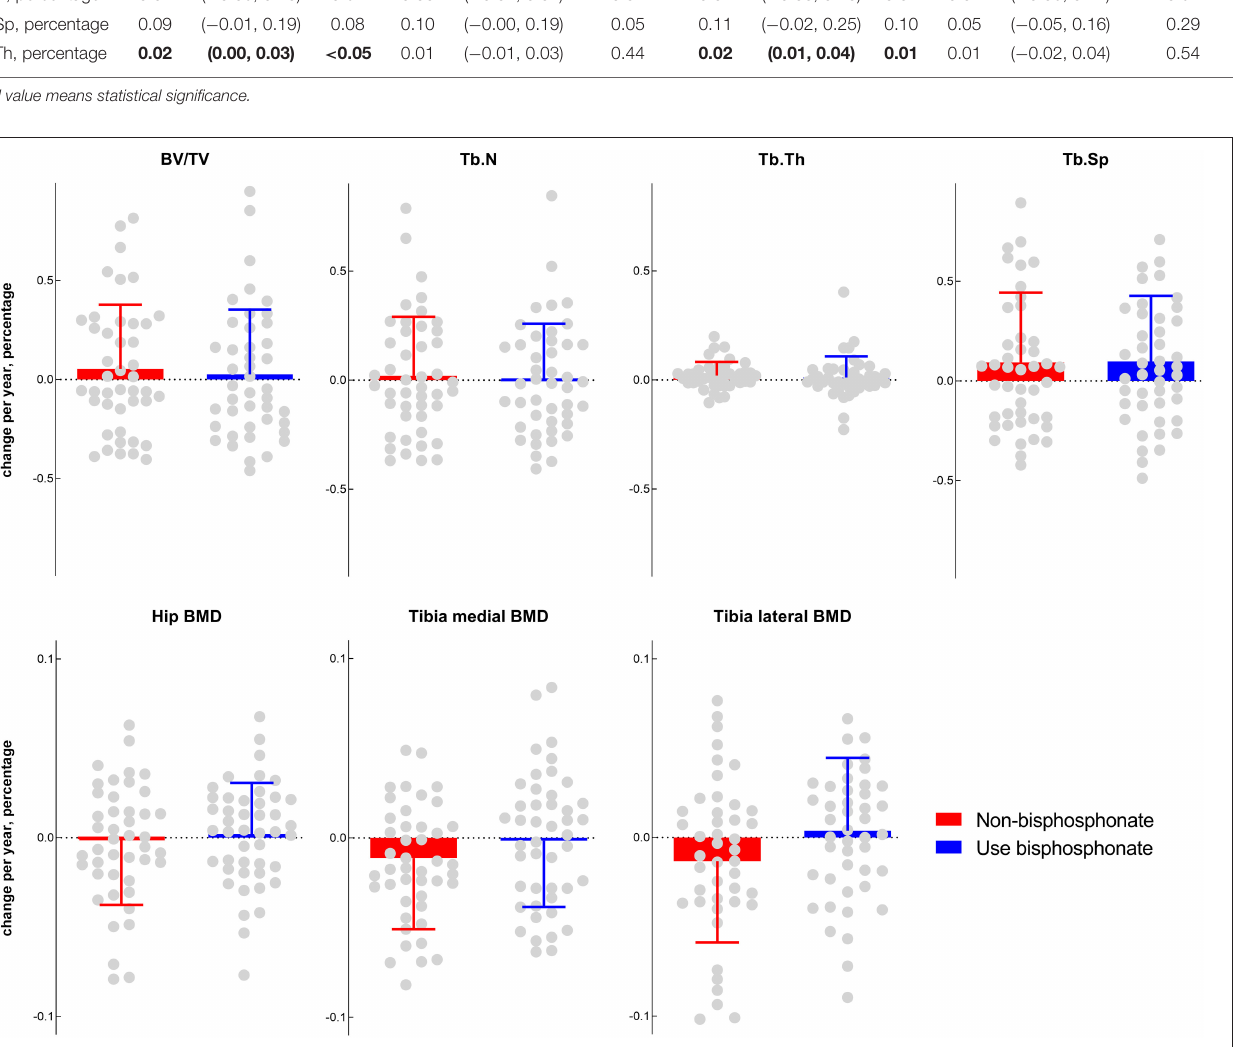
FIGURE 1 | Comparisons of subchondral bone morphometry and BMD between the bisphosphonate ever-use (in the previous 5 years) group and the non-bisphosphonate group.